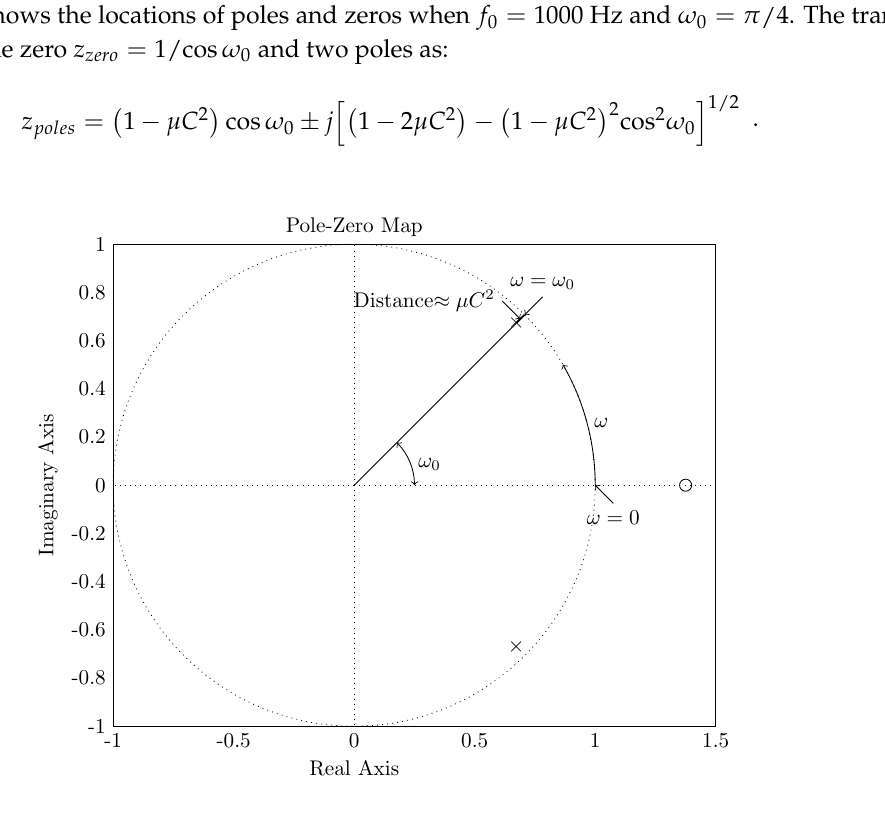
Figure 9. Poles’ and zeros’ locations of the transfer function H ( z )